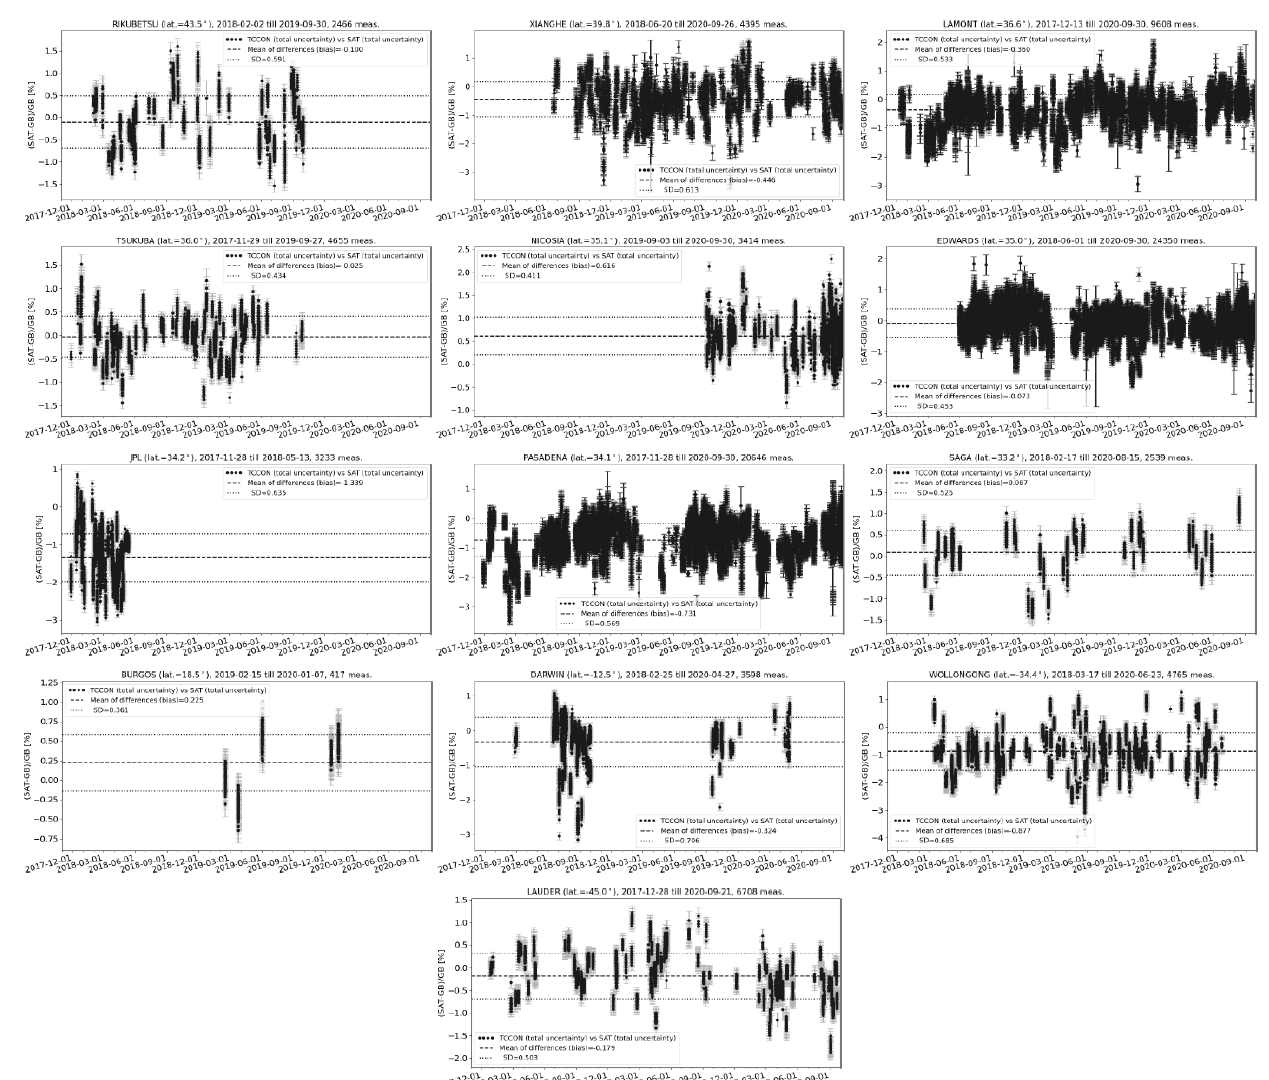
Figure 7. Same as Fig.